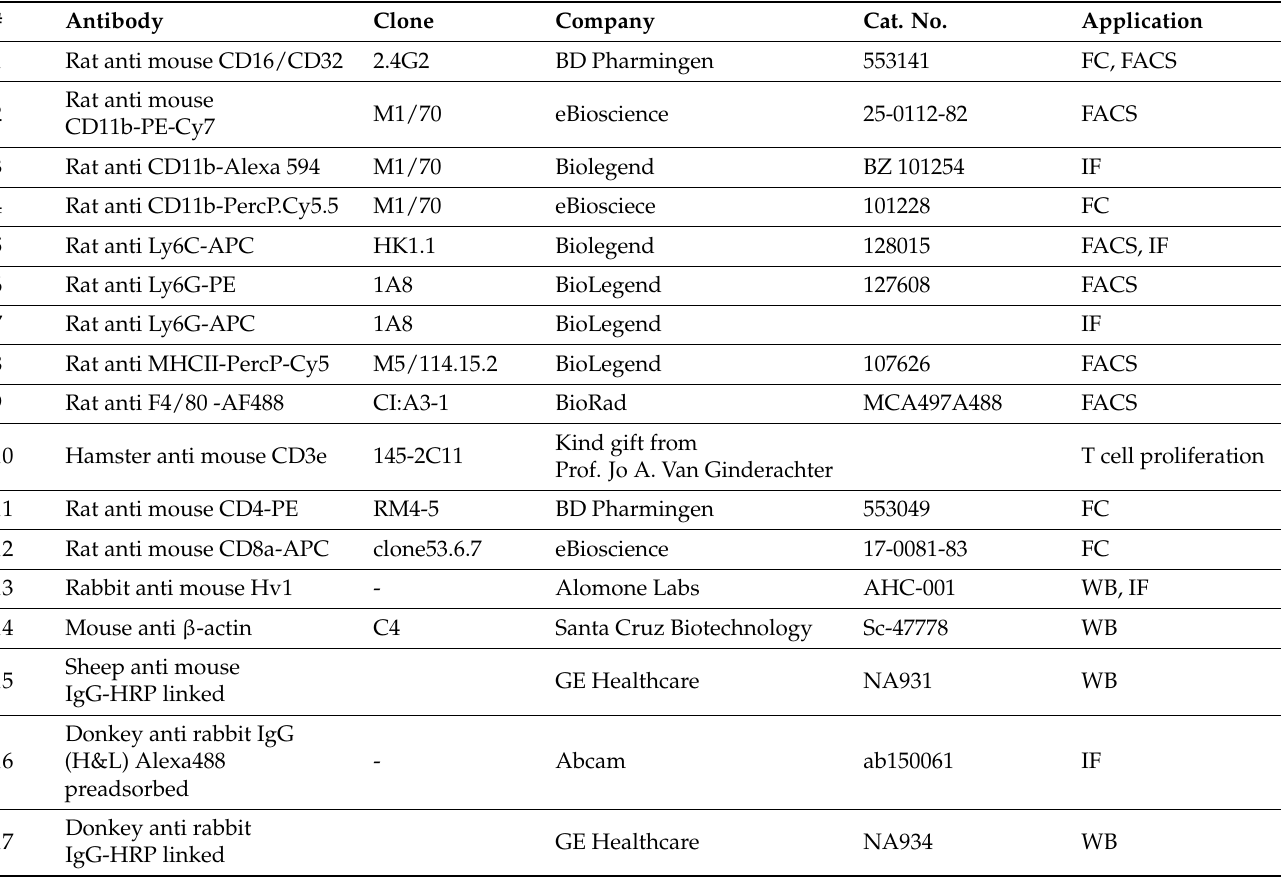
Table 1. List of antibodies